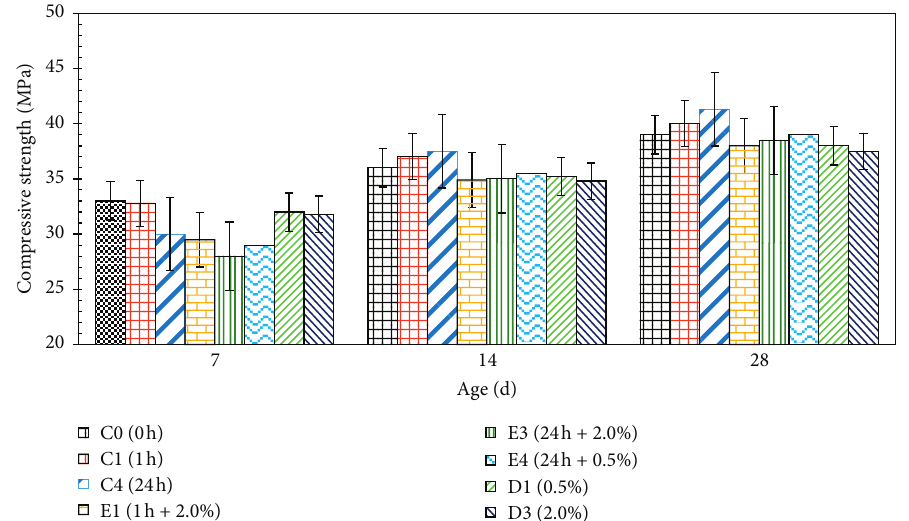
Figure 16: Influence of SRA, prewetting time, and a combination of SRA and prewetting time on the compressive strength of